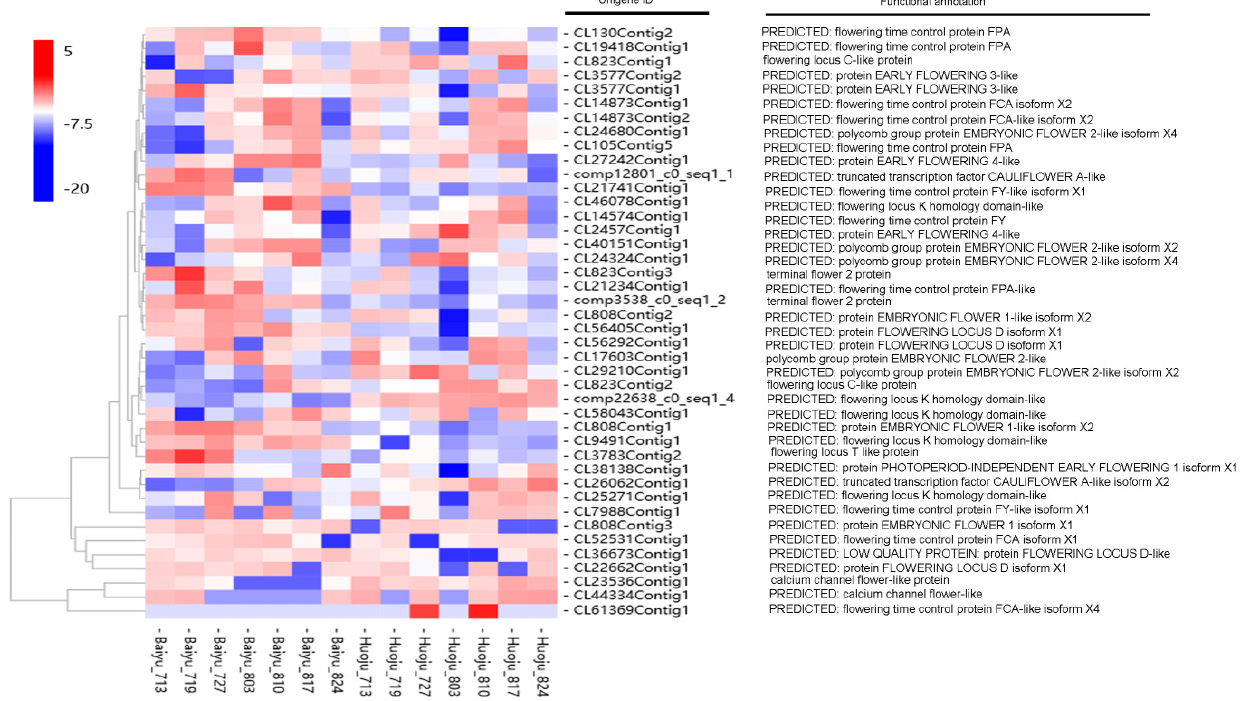
Figure 4. Heatmap of 42 unigenes involved in flowering time regulatory pathways.